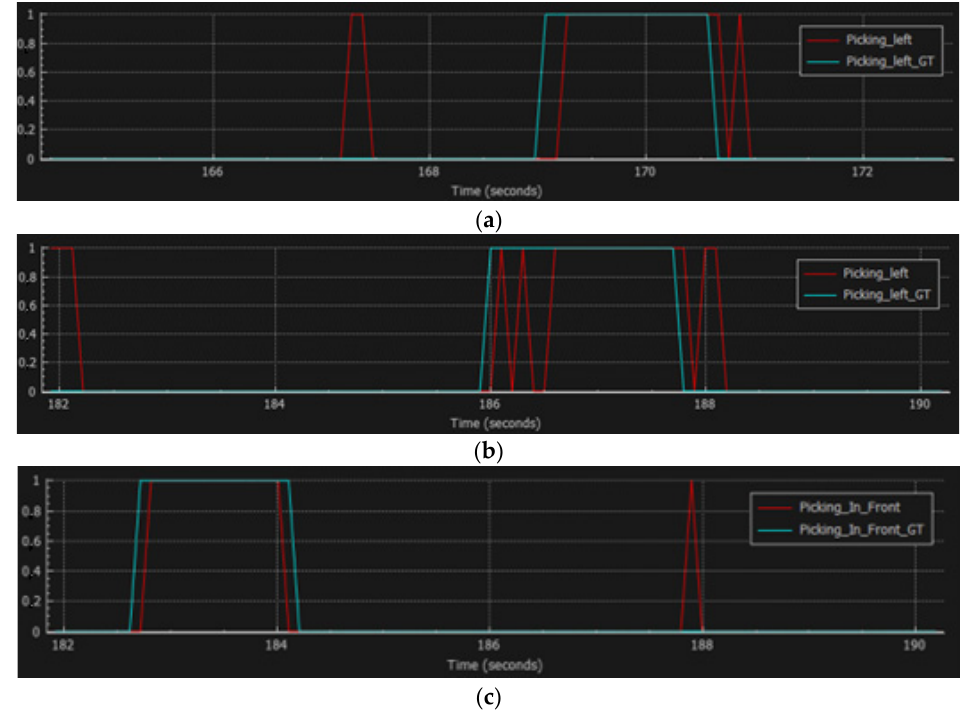
Table 4. Online accuracy results for each subclass.